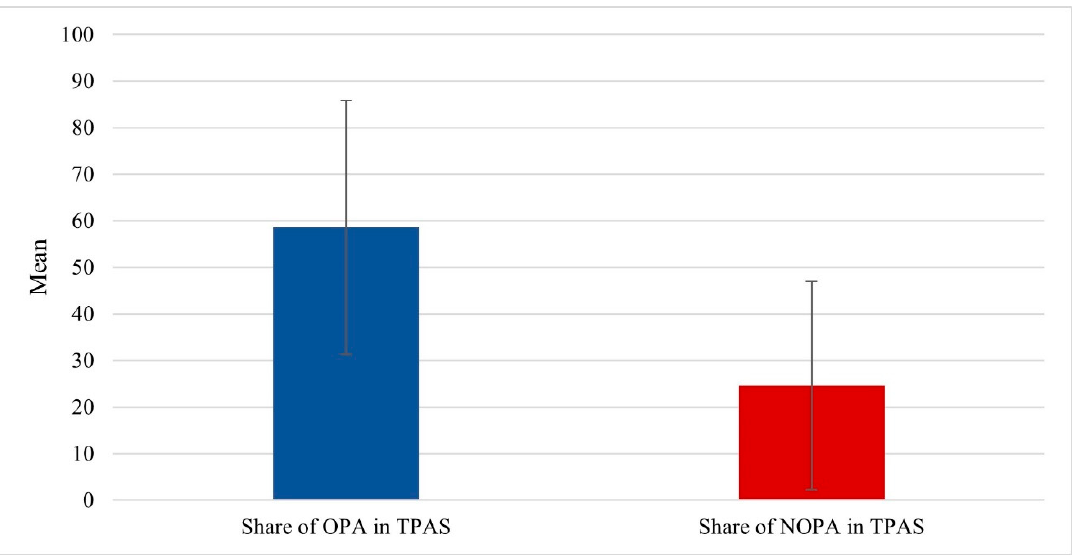
Figure 1. This is a figure. Average percentage of professional and non-professional activity in re-lation to total activity. OPA: Occupational Physical Activity; NOPA: Non-Occupational Physical Activity; TPAS: Total Physical Activity